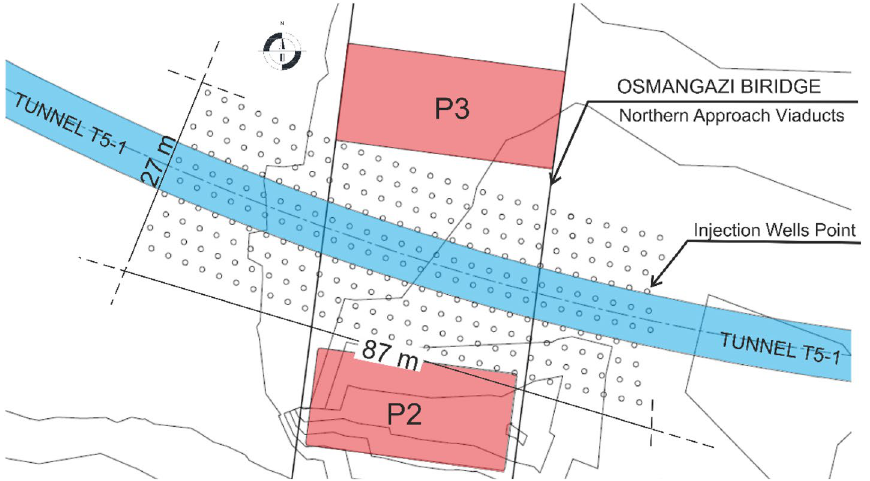
Fig. 9 Layout of injection wells on the T5-1 Tunnel route (Prohit